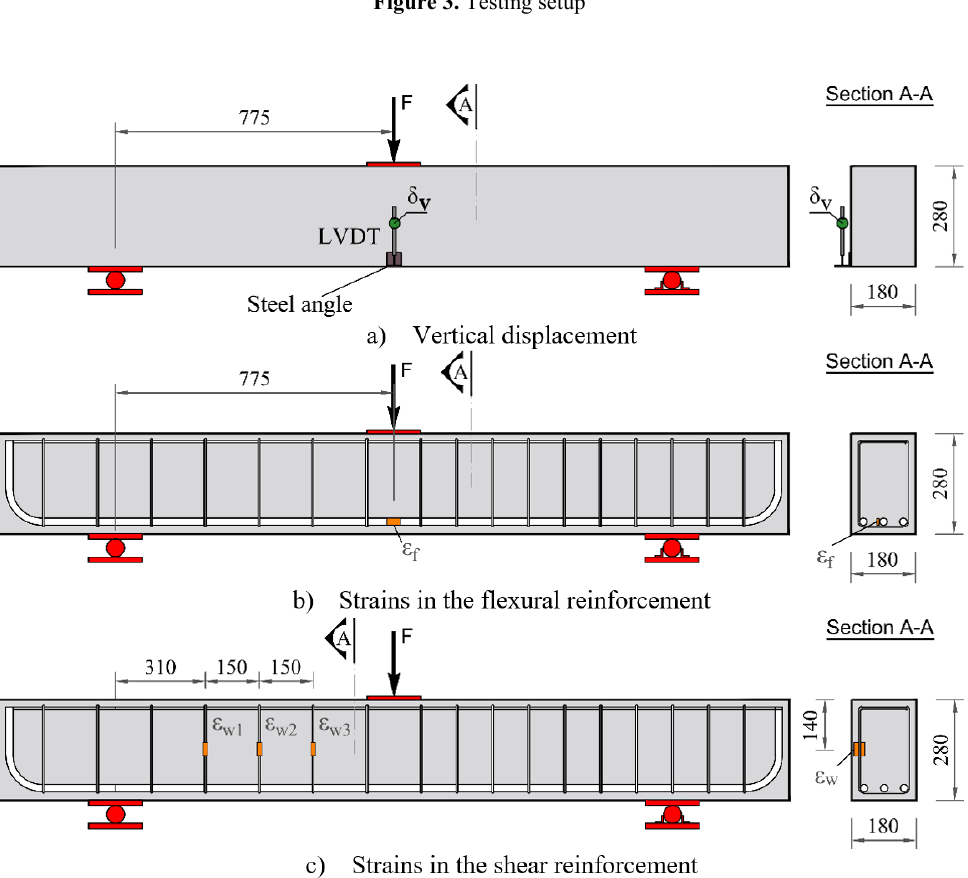
Figure 4. Instrumentation of the tested